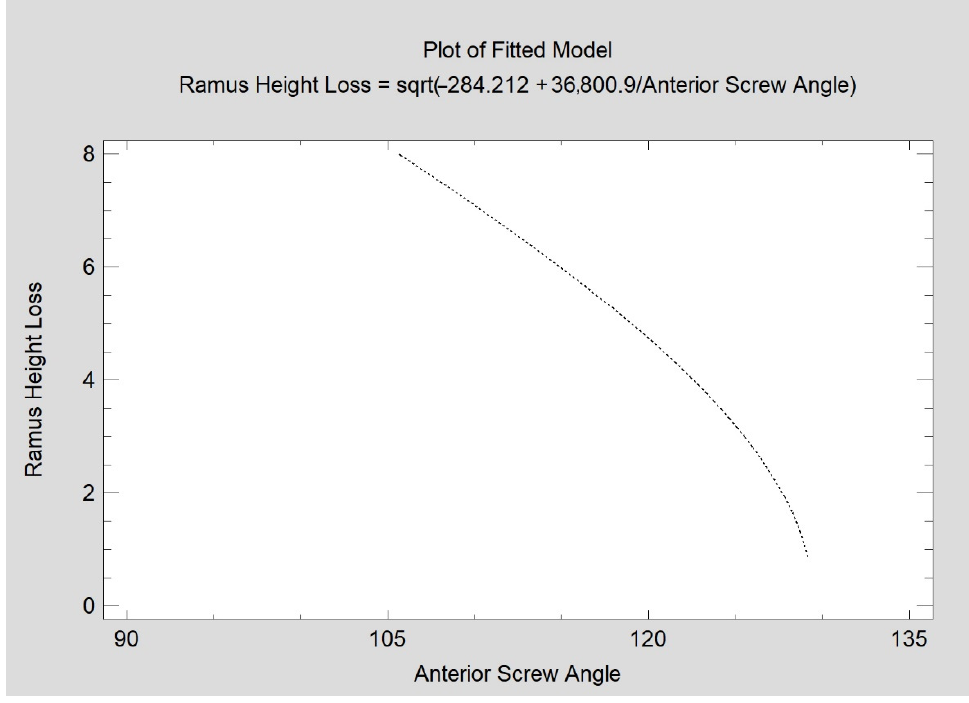
Figure 7. Relationship of mandibular ramus height loss (mm) measured 12 months post-operationally with angulation of the anterior fixing screw (degrees). The relationship is statistically significant ( p < 0.05).